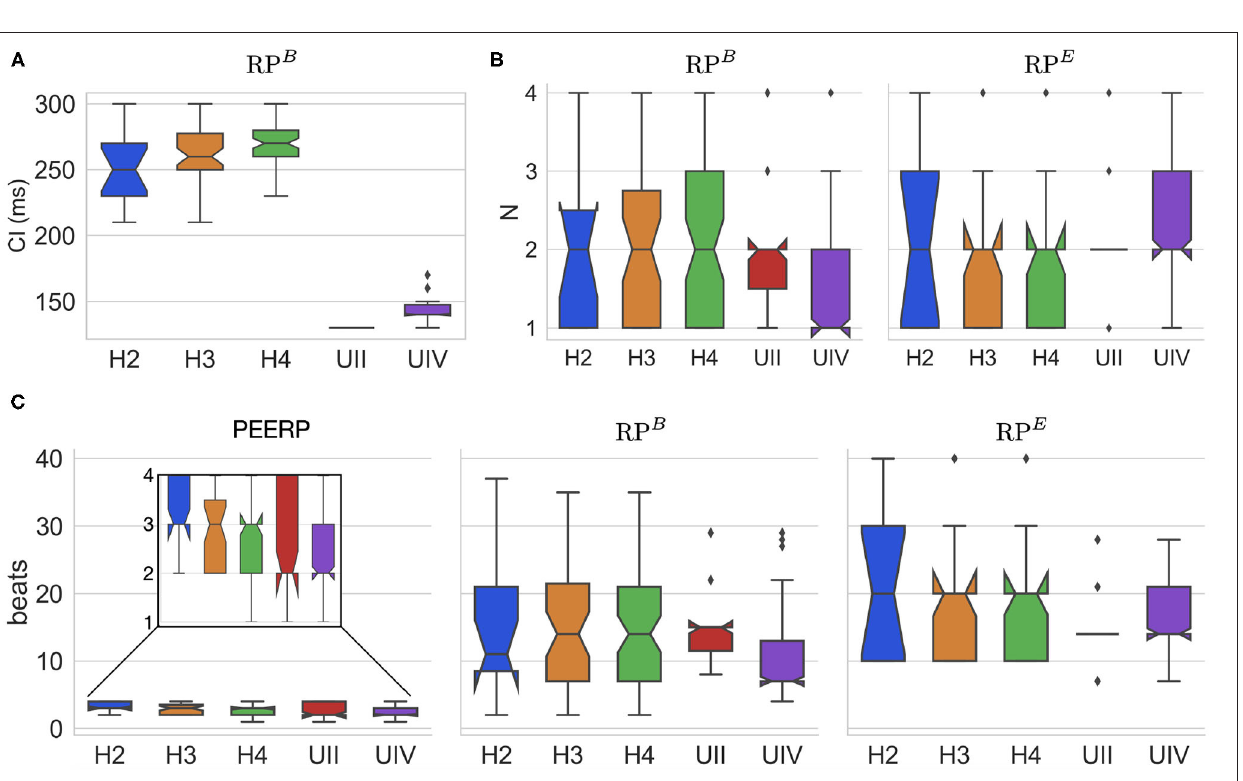
FIGURE 6 | (A) CI at which RP B induced arrhythmia in each atrial model. (B) Number of beats per CI ( N ) needed to initiate arrhythmia in both RP B and RP E . (C) Total number of beats applied in the protocols PEERP, RP B , and RP E inducing arrhythmic episodes.